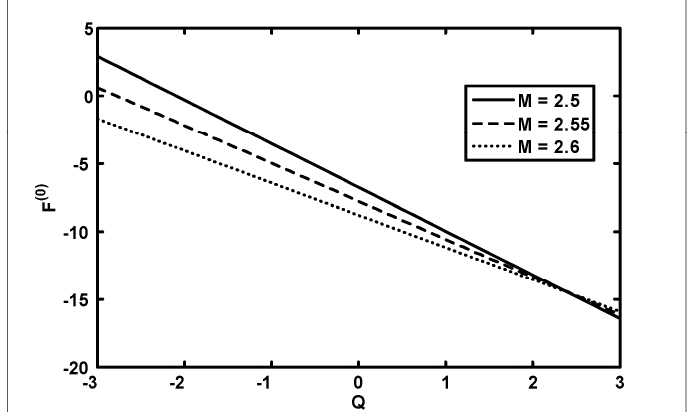
= 0.4, ϕ = 0.4, when µ = 1. Coatings 2019 , 9 , x FOR PEER REVIEW 10 of 20 0.4,φ 0.4, r = = when Figure 2. The variation of 1 1